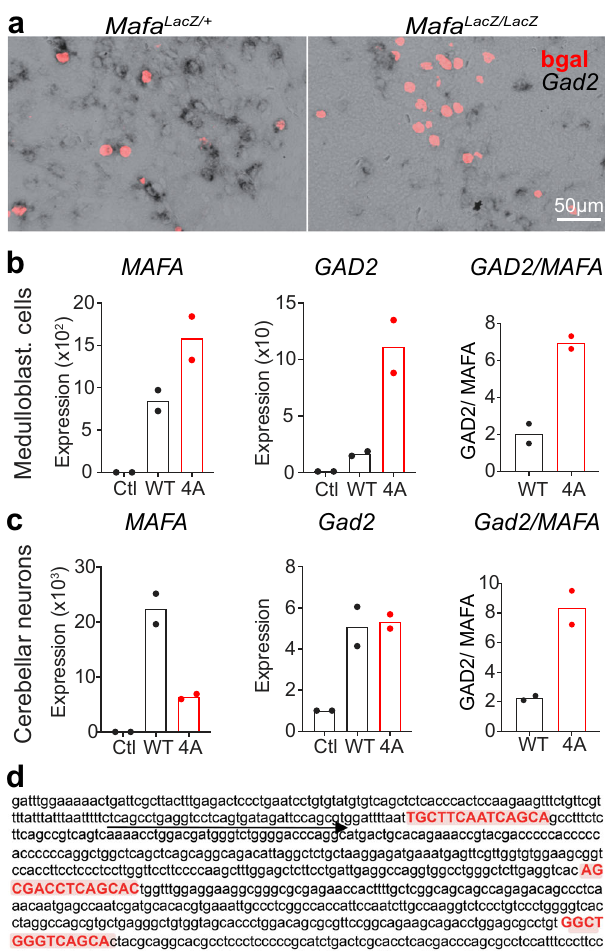
(medulloblastoma, DAOY) that do not express MAFA . As mea- sured by RT-qPCR, Mafa signi fi cantly increased GAD2 expres- sion in both cell lines (Fig. 5b) with GAD2 expression being four times higher in Mafa-4A expressing cells. These results were further con fi rmed on primary neuronal cells using mouse cere- bellum primordia cultures (Fig. 5c). Inspection of the Gad2 proximal promoter region revealed the presence of at least 3 potential Maf Responsive Element sequences (MARE 46 , Fig. 5d). A Gad2 promoter region containing these 3 potential MAREs was then cloned into the pGL3 Luciferase reporter vector (Gad2-Luc) and a medulloblastoma cell line was transfected with either control pGL3 (containing a minimal promoter without MAREs) or the Gad2-Luc vectors in the presence of increasing con- centrations of plasmids encoding WT or Mafa-4A protein. WT Mafa was found to activate the Gad2 promoter in a dose- dependent manner, with the Mafa-4A mutant protein being two times more potent (Fig. 5e). These data demonstrate that Gad2 is a direct Mafa target gene and that GSK3-mediated phosphor- ylation of Mafa likely attenuates GABAergic synaptic transmis- sion via a mechanism that lead to down control of Gad2 transcription.